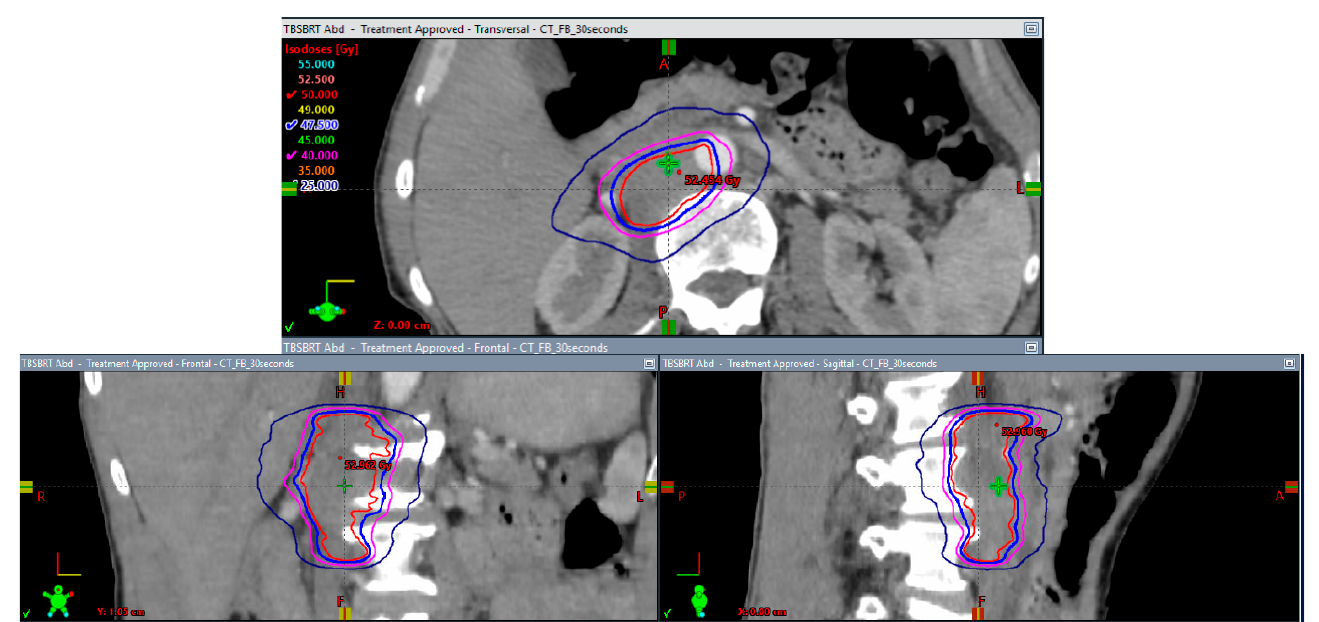
Figure 6. Axial, coronal, and sagittal isodose displays of the stereotactic body radiation (SBRT) plan to the aortocaval lymph node recurrence to 50 Gy in 5 fractions. Lines in red, blue, magenta, and navy correspond with 50 Gy, 47.5 Gy, 40 Gy, and 25 Gy, respectively.